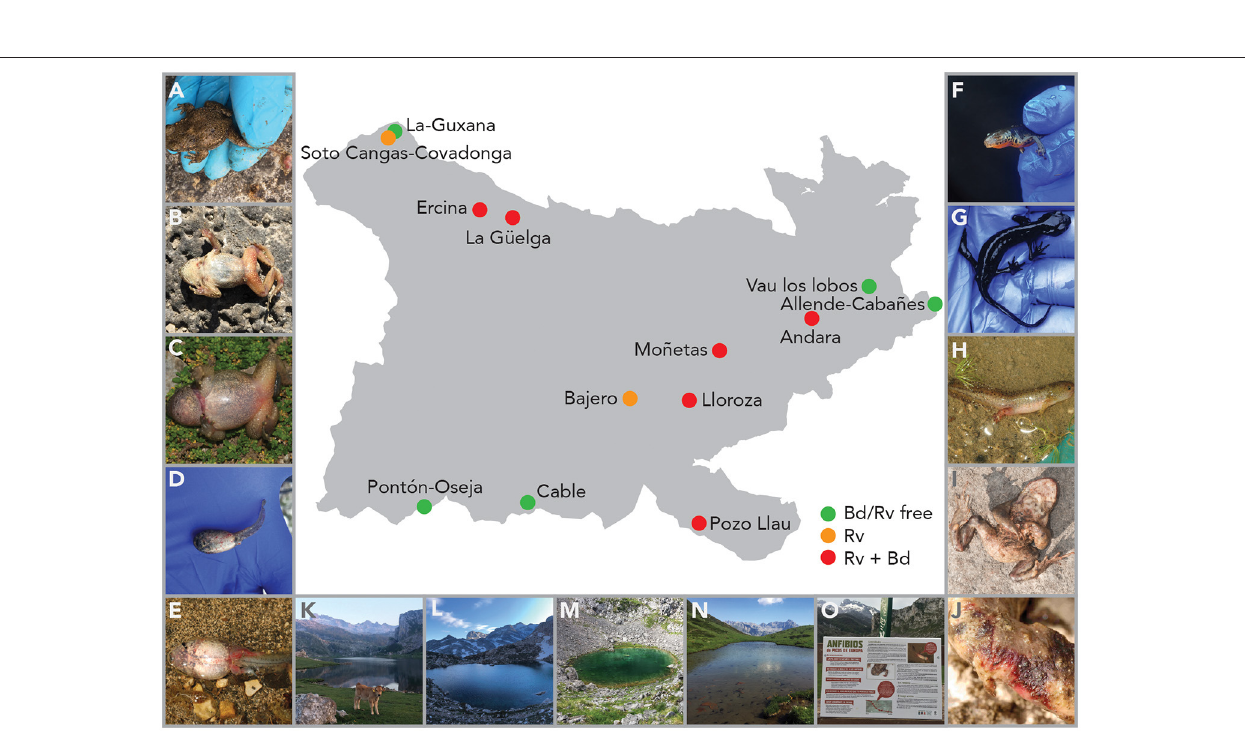
FIGURE 2 | Map of PNPE with sampling sites and signs of ranavirosis in three species. Alytes obstetricans adults with severe limb necrosis (A) or erythema (B) , metamorph with erythema and swelling of the body and legs (C) , and larvae with systemic hemorrhage (D, E) . Ichthyosaura alpestris adults with missing eyes (F) or cachexia (G) and larvae with systemic hemorrhaging (H) . Bufo spinosus adults with erythema (I) and with open lesion on the feet (J) . Study locations of Ercina (K) , Lloroza (L) , Moñetas (M) and Pozo Llau (N) , and signage to inform visitors about the presence of Rv in PNPE (O) .